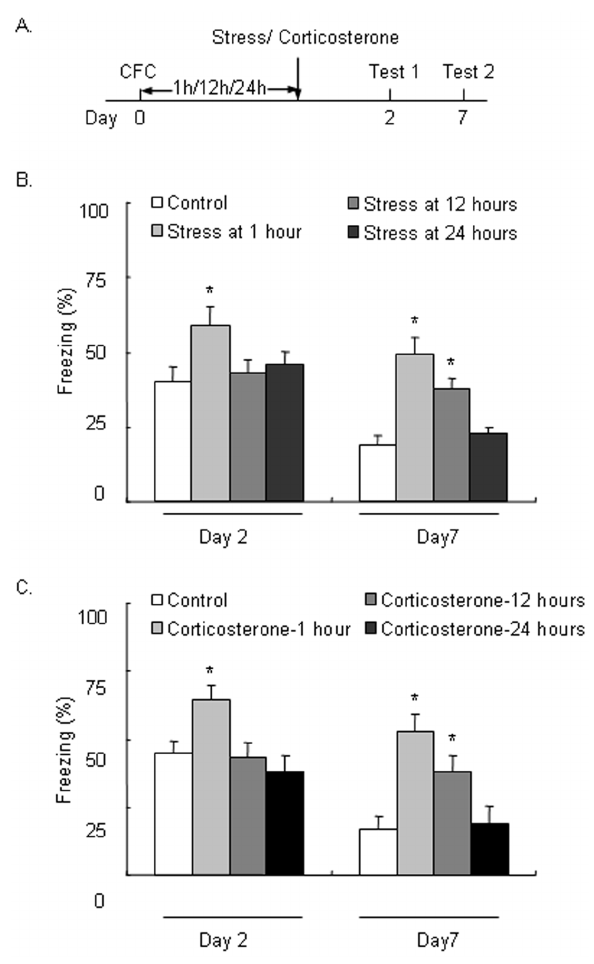
Figure 1. Stress and corticosterone administered 12 h after fear conditioning selectively enhanced the persistence but not formation of long-term memory. (A) Rats were exposed to cold water stress or administered corticosterone 1, 12, or 24 h after weak contextual fear conditioning (CFC) and then tested for long-term memory (LTM) on day 2 and day 7. (B) Stress exposure 1 h after CFC enhanced LTM formation tested on day 2, whereas stress exposure 12 h after CFC selectively enhanced the persistence of LTM tested on day 7 but did not affect LTM formation tested on day 2. (C) Corticosterone administration 1 h after CFC enhanced LTM formation tested on day 2, whereas corticosterone administration 12 h after CFC selectively enhanced the persistence of LTM tested on day 7 but did not affect LTM formation tested on day 2. The data are expressed as mean 6 SEM ( n =6–9 per group). * p , 0.05, compared with Control